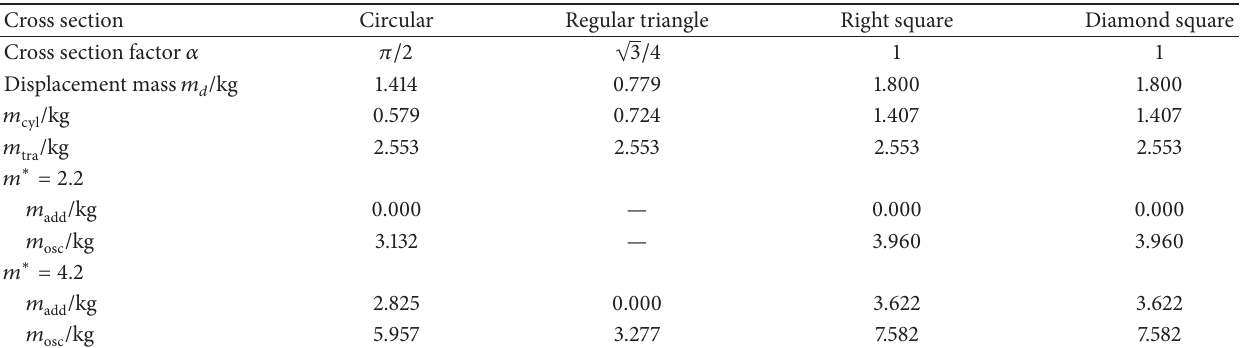
Table 1: The physical parameters of different